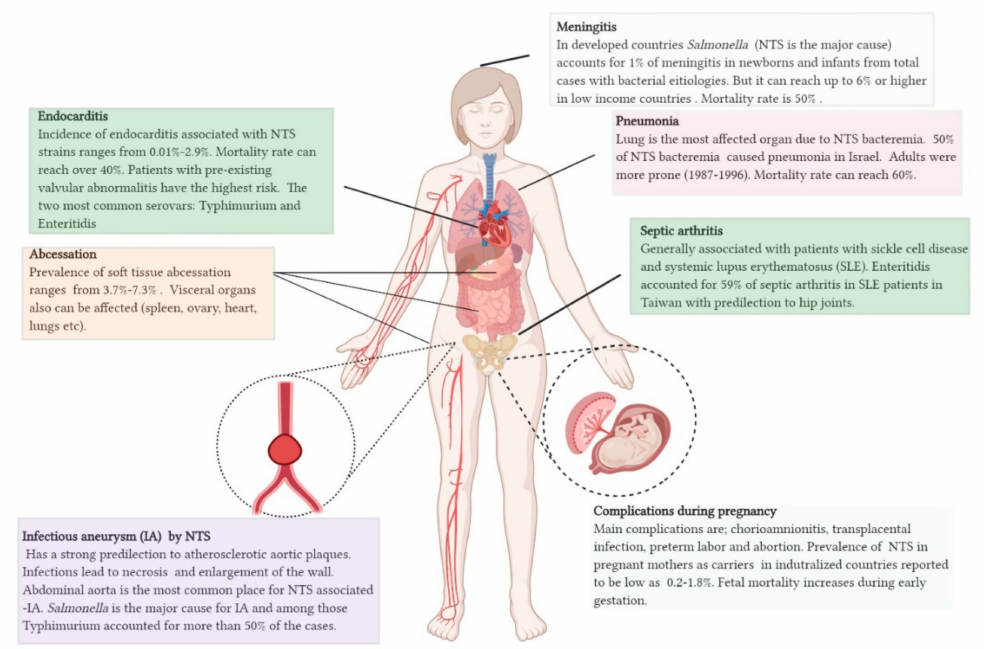
Figure 2. Bacteremia-induced complications by non-typhoidal Salmonella . Generally, 5% of gastroenteritis cases develop into bacteremia-associated complications in immunocompetent